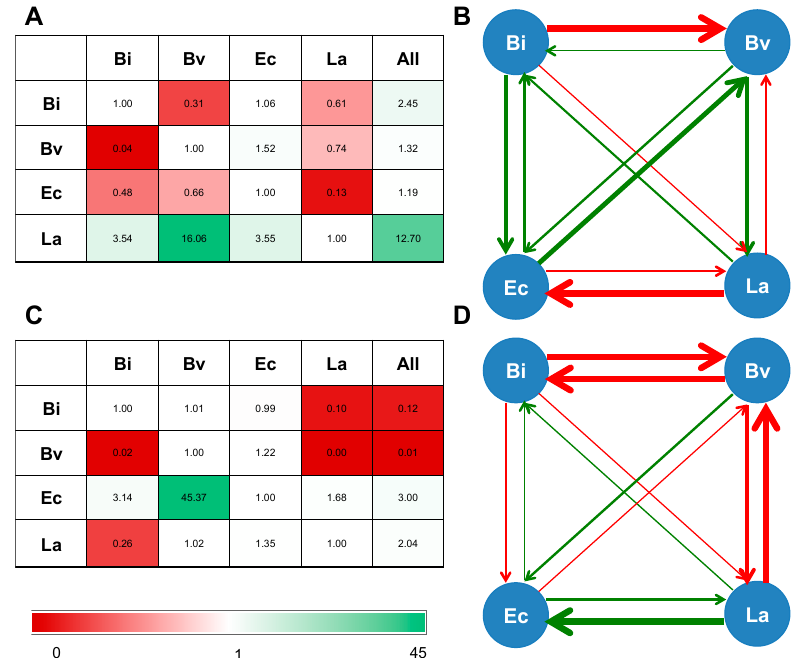
Figure 4. Interactions among members of the consortium. ( A , C ) Effect of microbes in the first row on the maximum growth of microbes in the first column. This was calculated for data on growth on 2FL ( A ) or FOS ( C ). A value of 1 means no effect, and legend indicate this normalized ratio; ( B , D ) effect of bacteria in the consortium on the growth rate of one microbe, in 2FL ( B ) or FOS ( D ). Arrows indicate the direction of this effect. Red indicates a negative effect on growth rate (competition), and green indicate a positive value (cooperation). Width of arrows are proportional to the calculated effect (shown in Table S4).